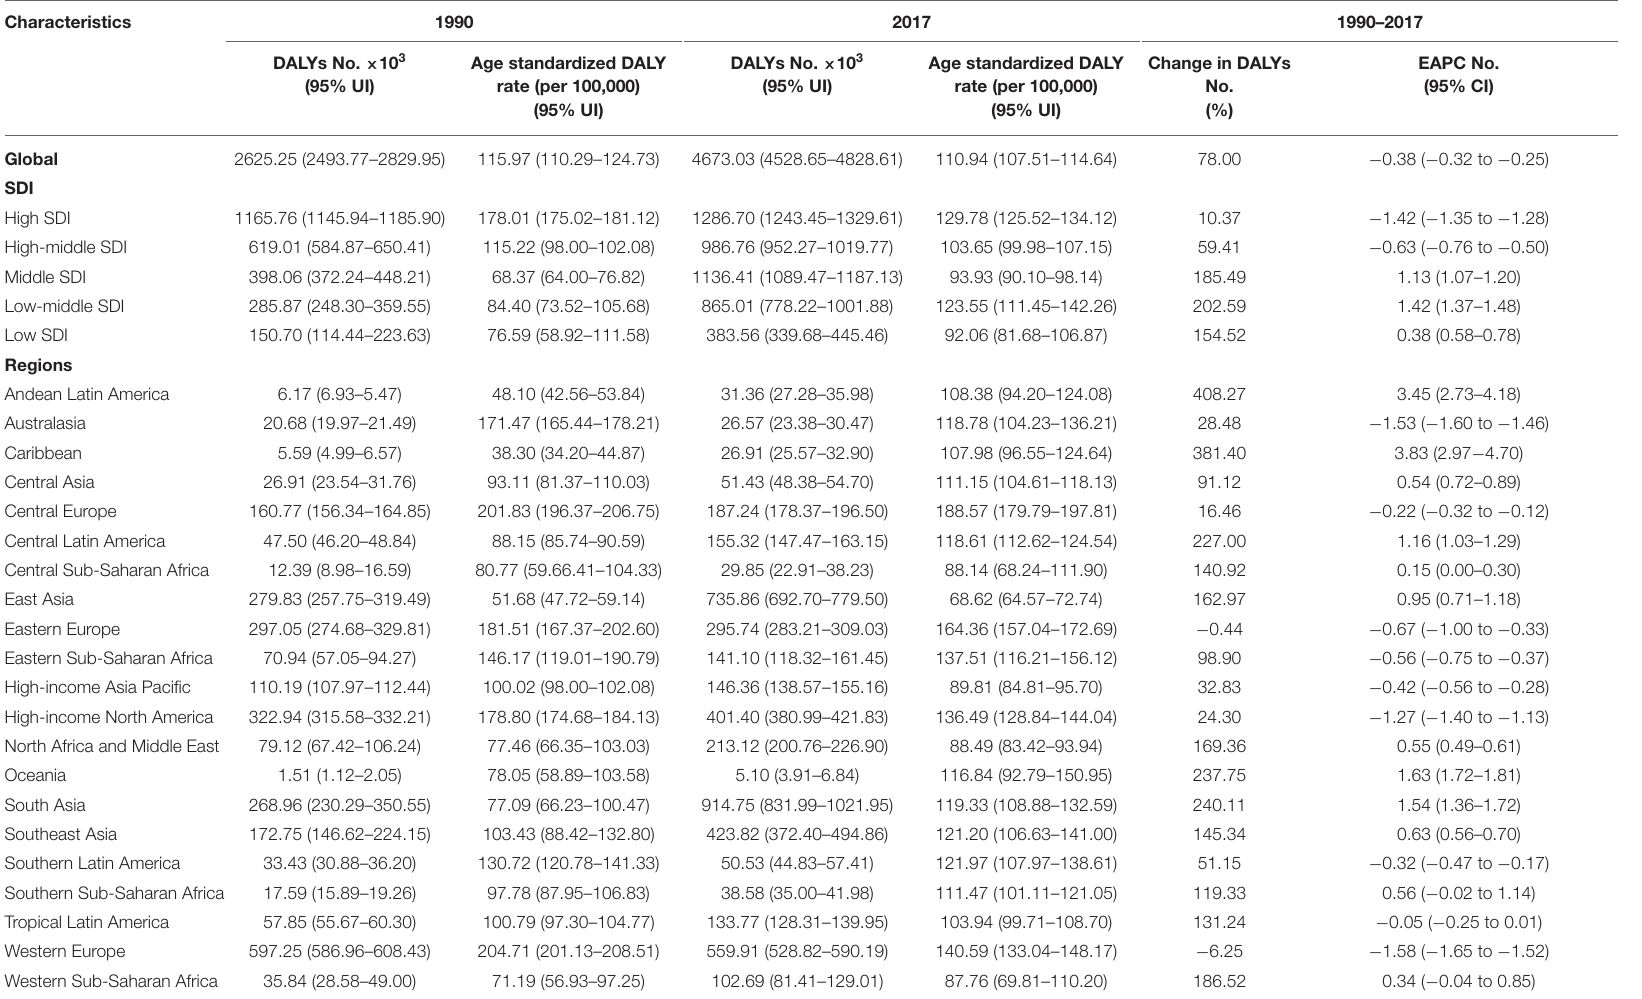
TABLE 3 | The DALYs of ovarian cancer, and its temporal trends from 1990 to